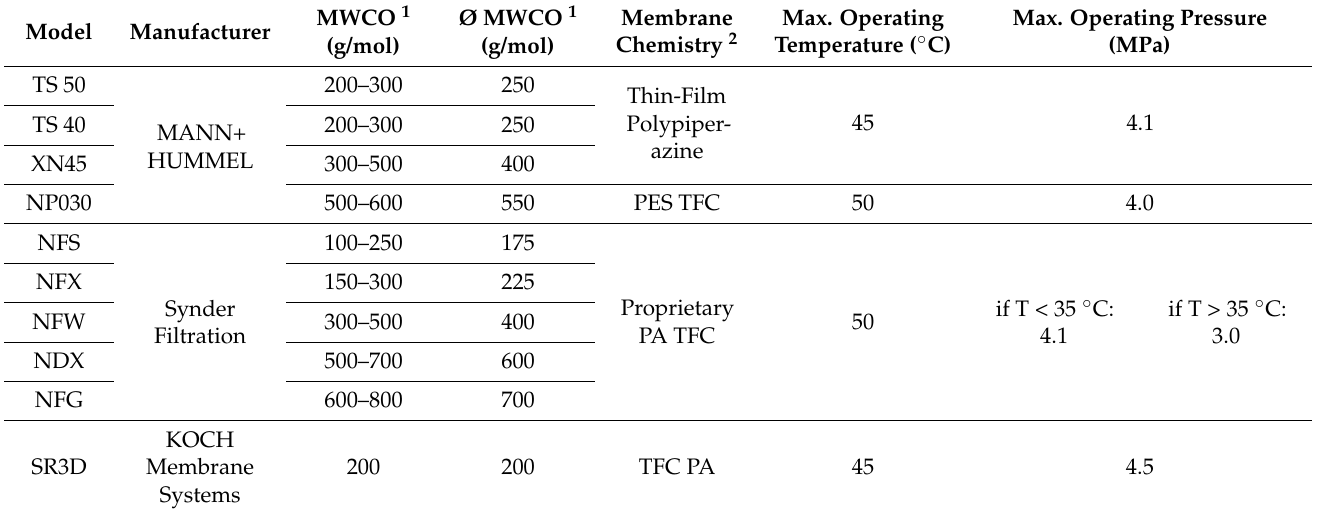
Table 2. Overview of the nanofiltration membranes used in this